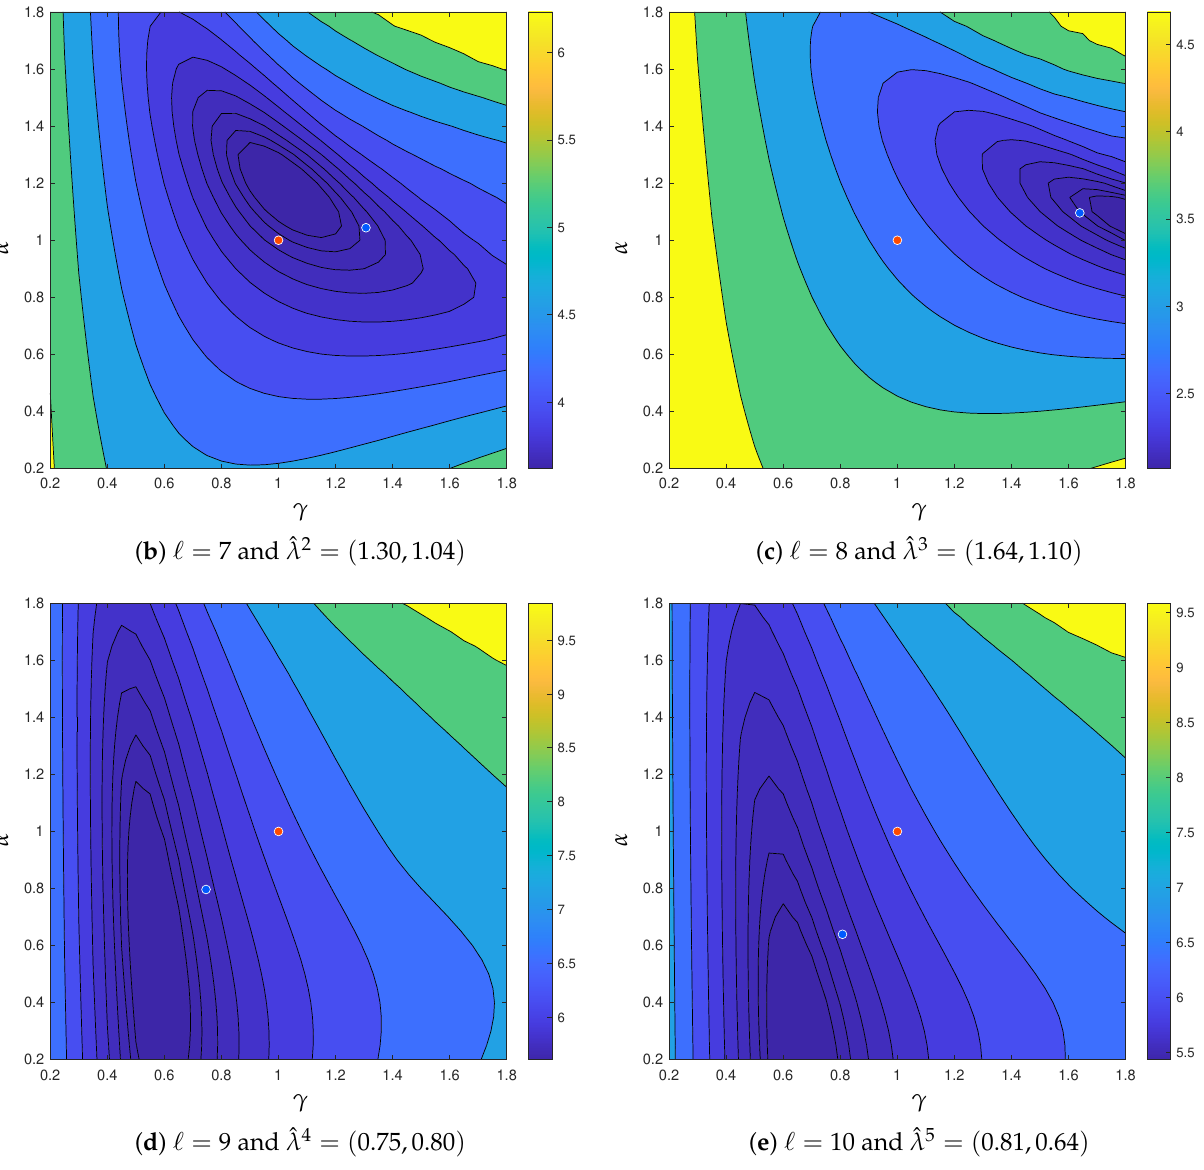
Figure 14. Contour map of evaluation function values D ( (cid:96) , z ( K )) with projection y (cid:96) for parameters γ , α . Blue and red points indicate ˆ λ (cid:96) − 5 and ( 1,1 ) corresponding to the MLEM algorithm,